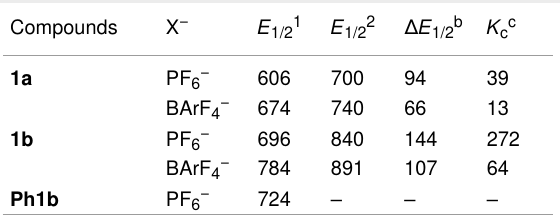
Table 1: Electrochemical data for 1 in CH 2 Cl 2 . a